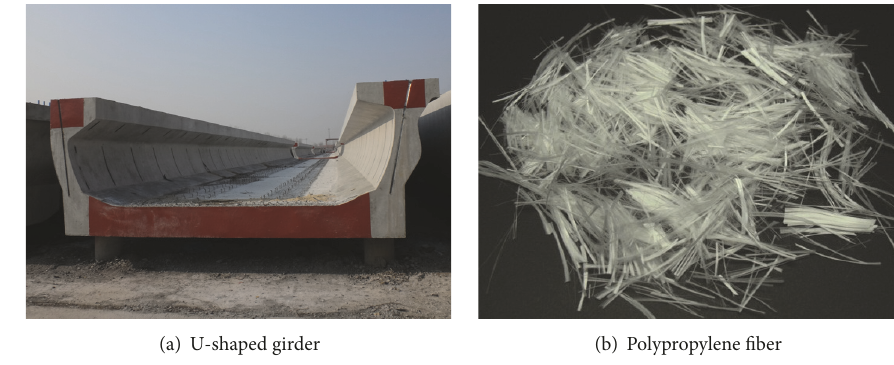
Figure 2: Photographs of U-shaped girder and polypropylene